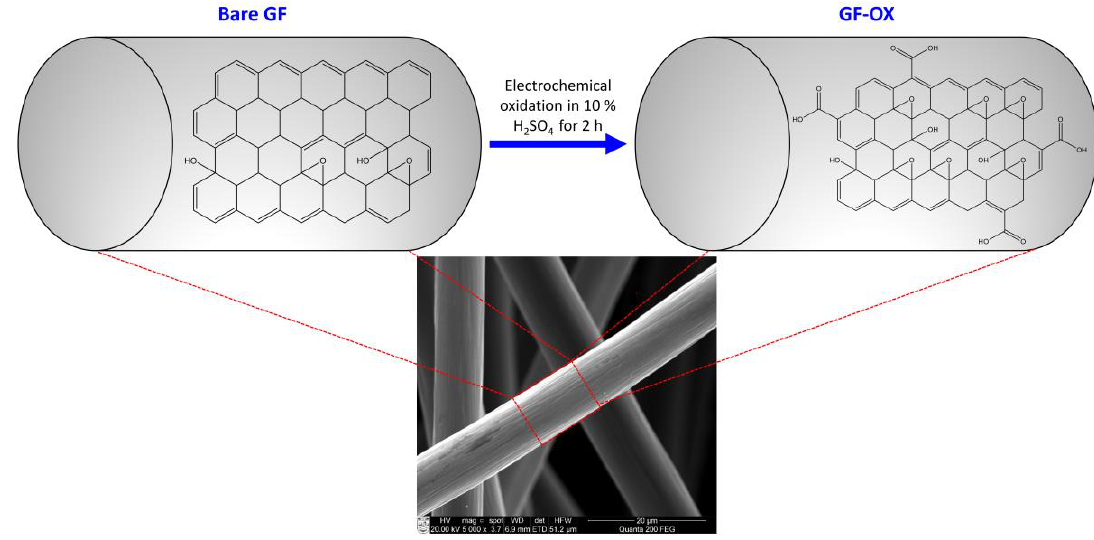
Figure 1. Schematic representation of electrochemical oxidation of graphite felt (GF) in 10% H 2 SO 4 solution.